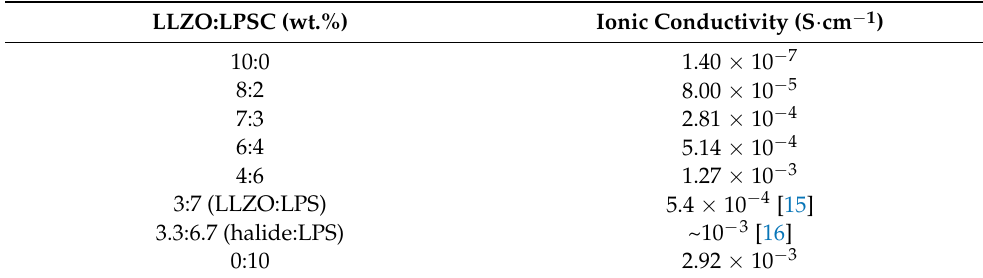
LLZO:LPSC = 8:2 composite electrolyte and the rule of the mixture effect. Table 1 indicates that the conductivity of the LPSC electrolyte was 2.92 × 10 − 3 S · cm − 1 . Although the